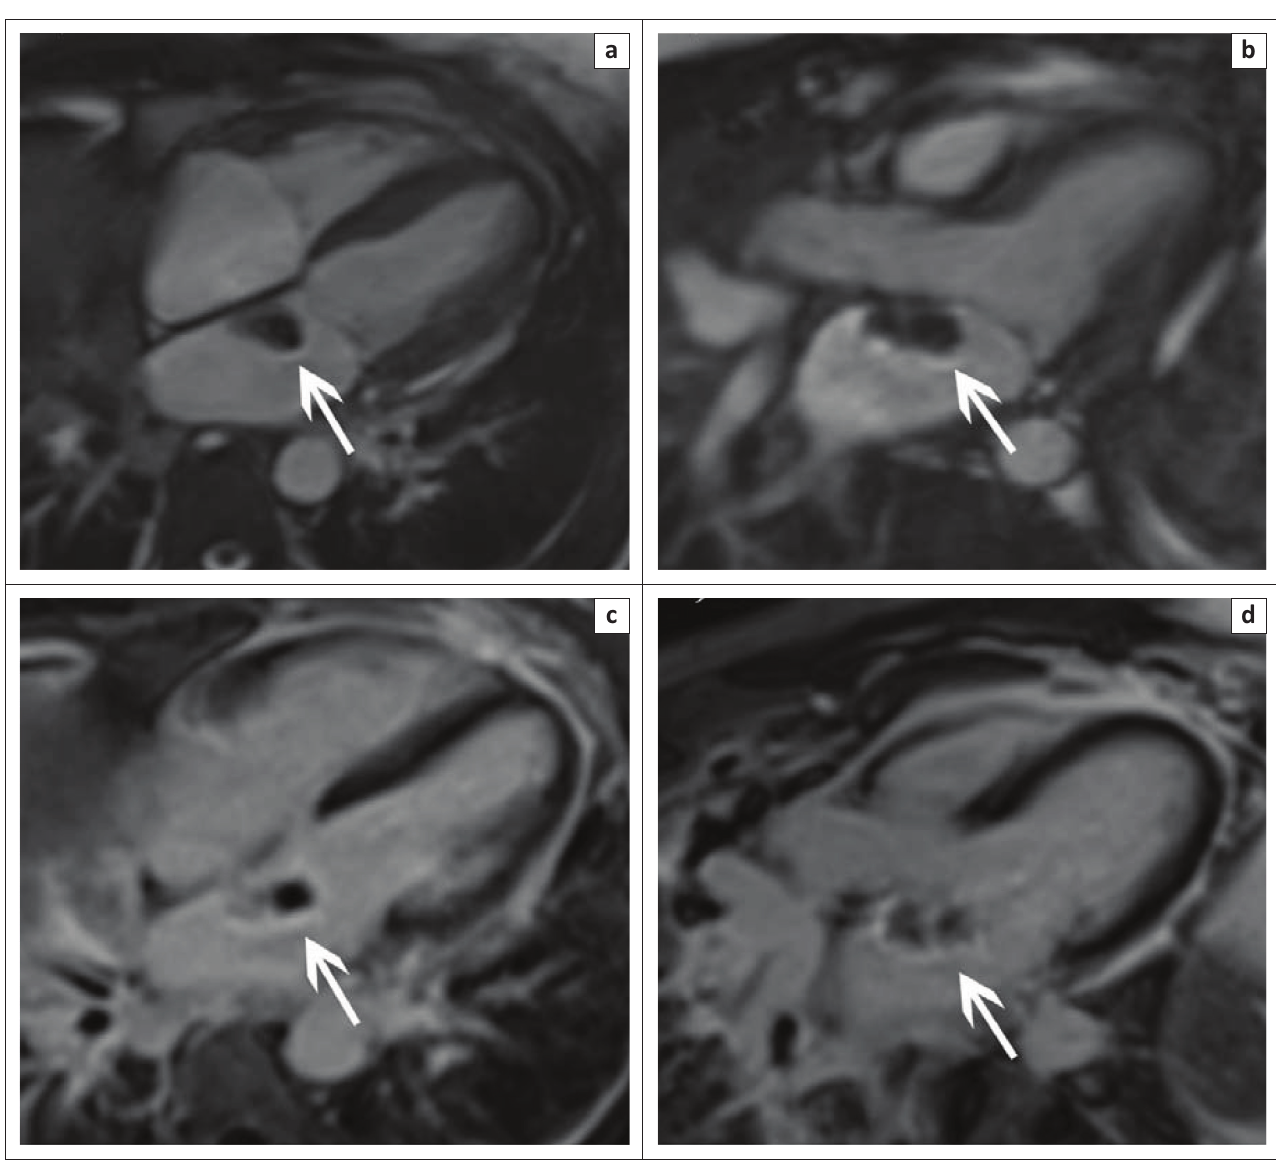
FIGURE 10: Four-chamber (a) and 3-chamber (b) SSFP sequences in a patient with known lymphoma show an isointense left atrial mass (arrows) arising from the inter- atrial septum. Corresponding late gadolinium-enhanced images (c and d) show heterogeneous enhancement of the The imaging findings of HIV-associated PAH are the pulmonary trunk, main pulmonary arteries and eventually indistinguishable from those of primary PAH, with the right ventricle (RV) and right atrium. Cine imaging is morphologic abnormalities observed including, dilatation of used for the quantification of RV indices (end systolic and